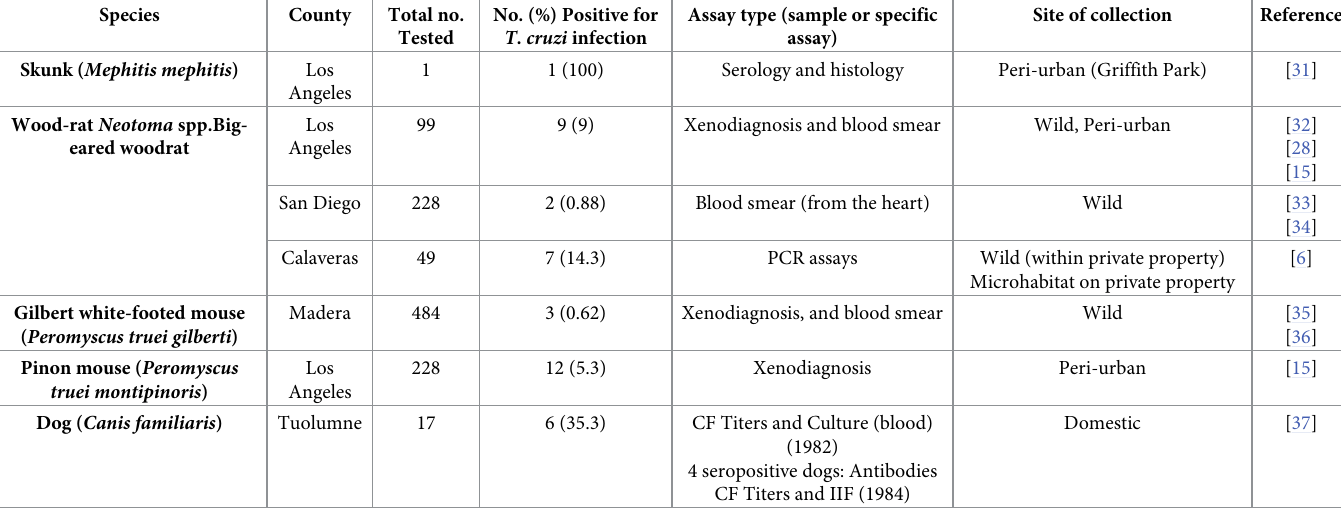
Table 3. Natural T . cruzi infection among mammals, according to the county.